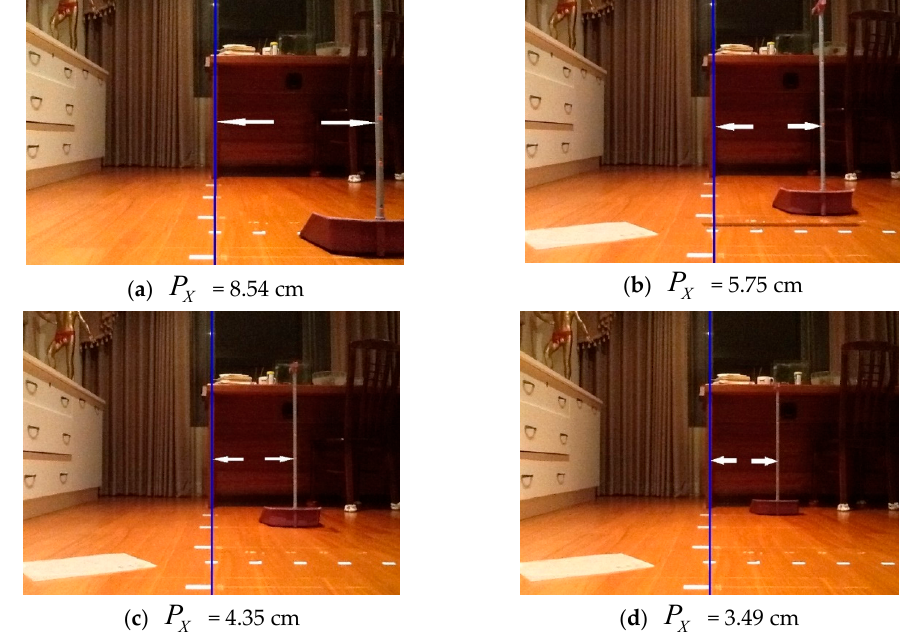
Figure 9. Focal length f measurement ( Q X = 36 cm). ( a ) P X = 8.54 cm; ( b ) P X = 5.75 cm; ( c ) P X = 4.35 cm; ( d ) P X = 3.49